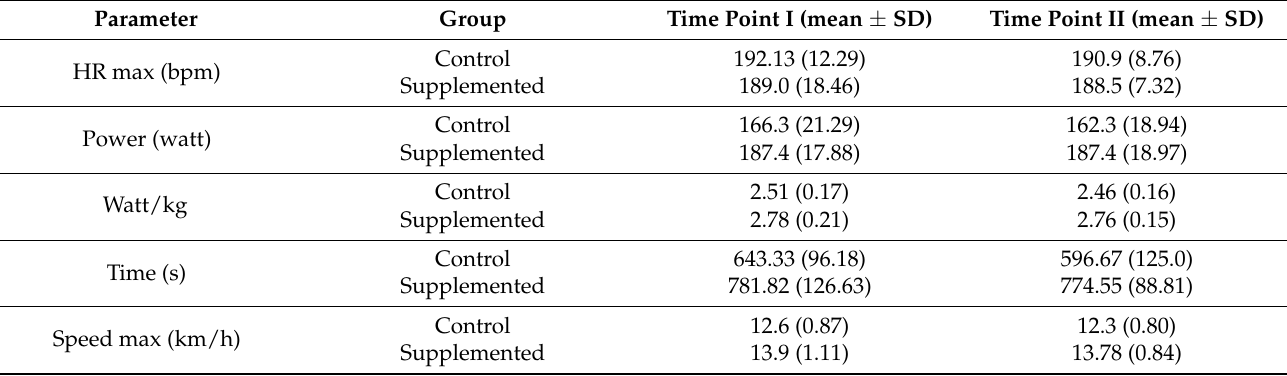
Table 2. Basic characteristics of the studied groups before and after supplementation (mean ± standard deviation (SD)).